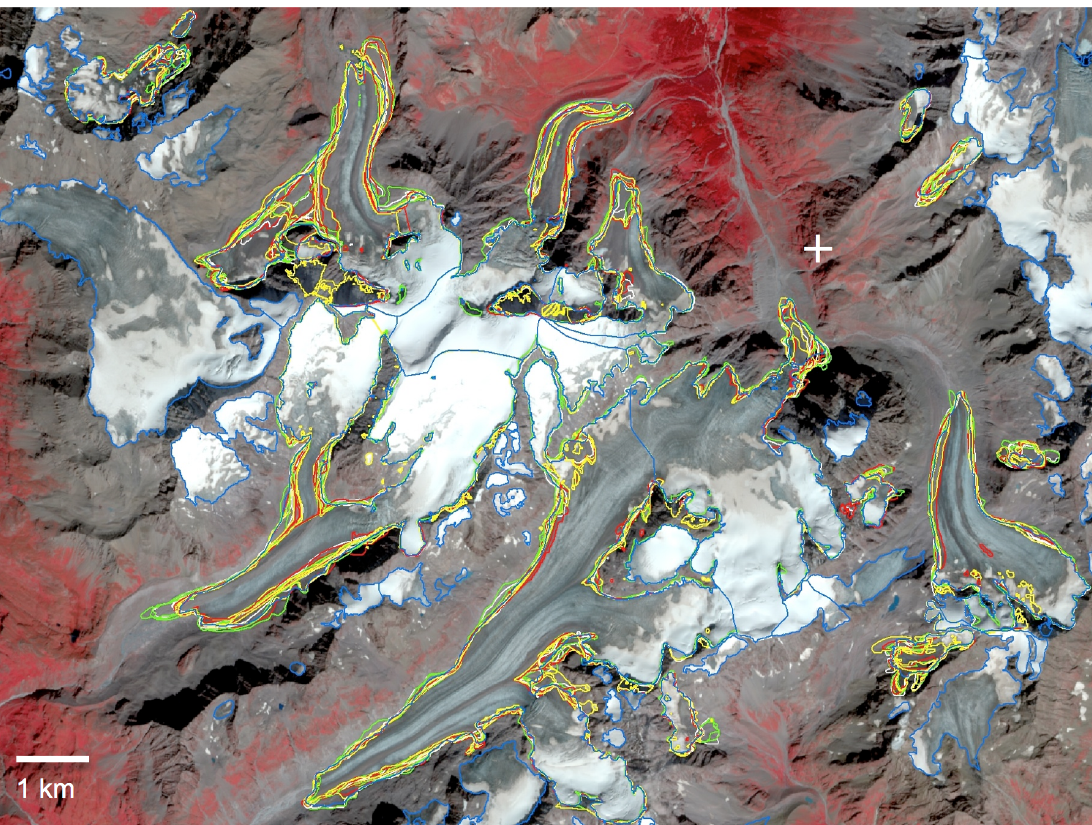
Figure 11. Overlay of glacier outlines from the multiple digitizing experiment by all participants. Colours refer to the first (yellow), second (red), third (green), and fourth (white) rounds of digitization. The white cross on the upper right marks the coordinates 46.0 ◦ N, 7.5 ◦ E (image source: Copernicus Sentinel data